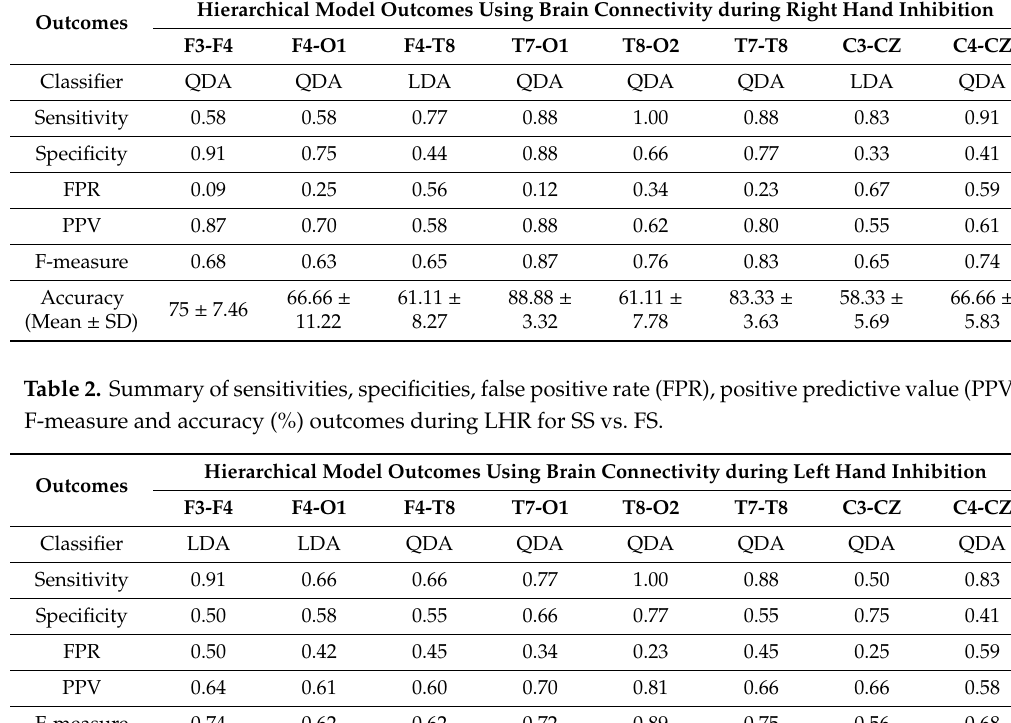
Table 1. Summary of sensitivities, specificities, false positive rate (FPR), positive predictive value (PPV), F-measure and accuracy (%) outcomes during RHR for SS vs. FS.